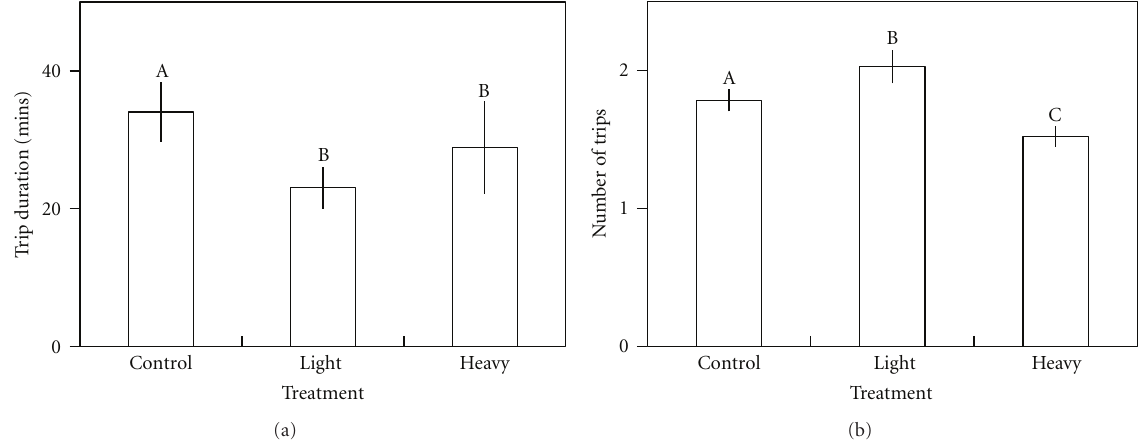
Figure 3: Mean ( ± 1SE) (a) duration in minutes and (b) number of foraging trips per bee for each treatment group. Bars that share the same letter did not significantly di ff er using post hoc